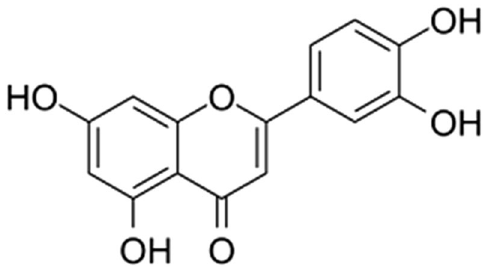
Fig. 7 Structure of luteolin (3 ′ ,4 ′ ,5,7-tetrahydroxyflavone) Fig. 8 Structure of genistein (4 ′